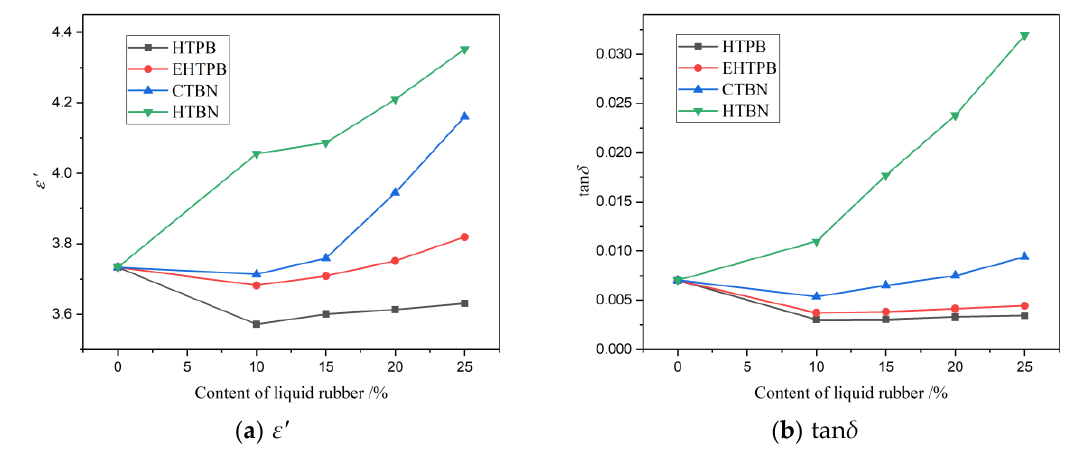
Figure 5. The ε ′ and tan δ of epoxy resin matrix vary with the content of liquid rubber. ( a ) ε ′; ( b ) tan δ . For the sample with HTBN, the ε ′ and tan δ increase with the increase of filler content. For the sample with HTPB, EHTPB, and CTBN, the ε (cid:48) and tan δ decrease first and then increase with the increase of filler